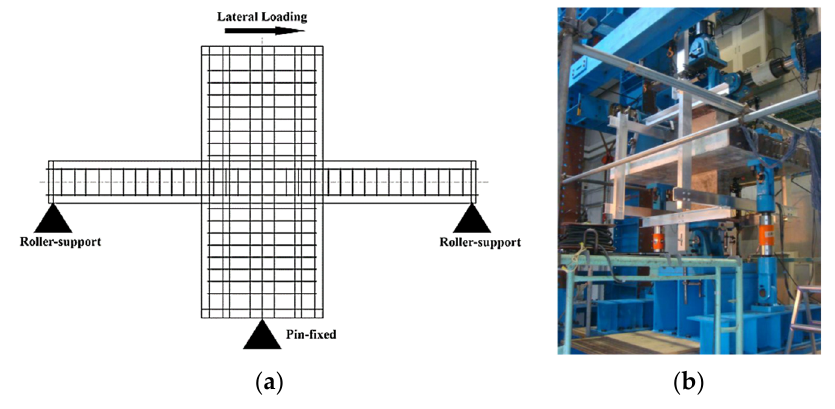
Figure 8. ( a ) Support condition and ( b ) Photograph of the specimen [11,12].